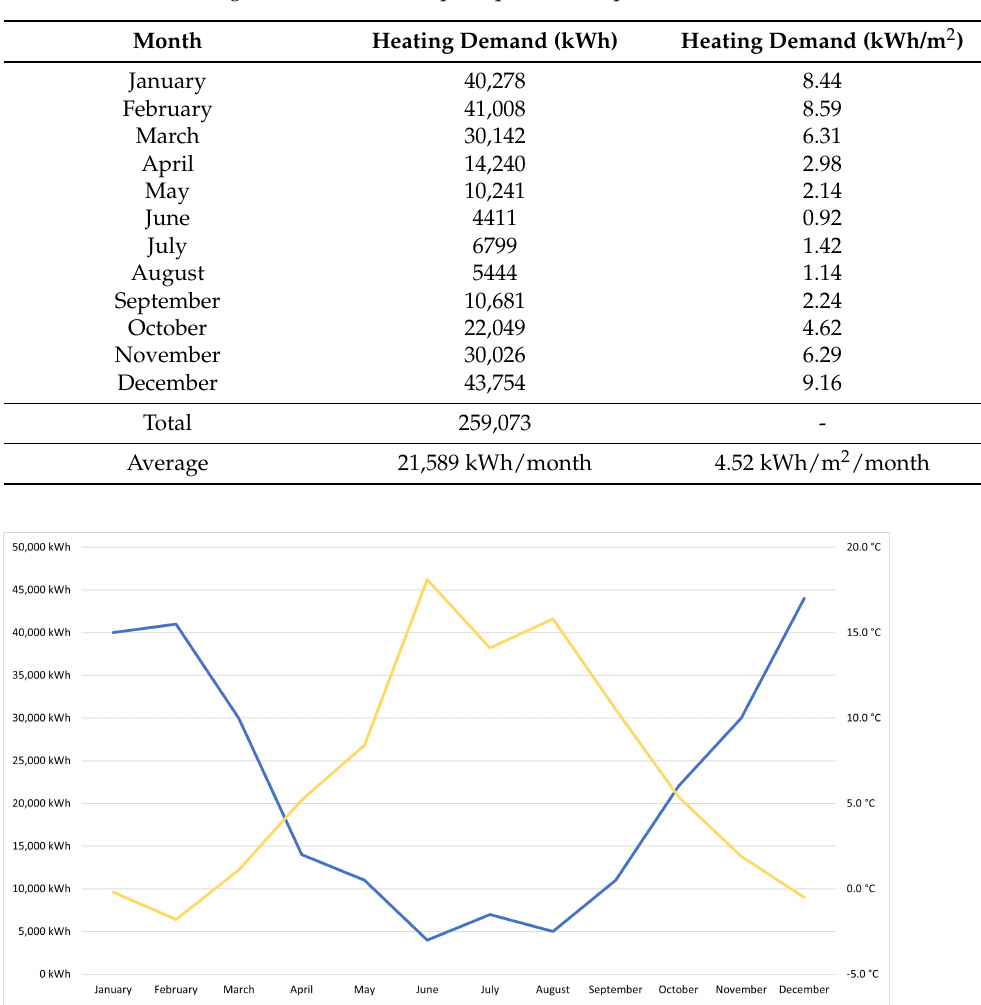
Figure 5. Electricity consumption, production, import and export in 2020. Table 4. District heating demand. Total and per square meter per month.